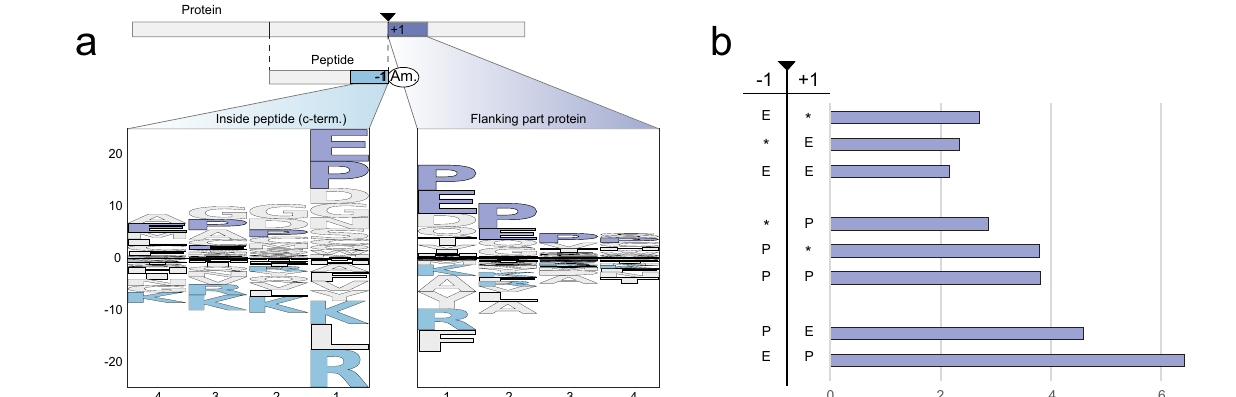
individual tissues into a consolidated score for each peptide across all